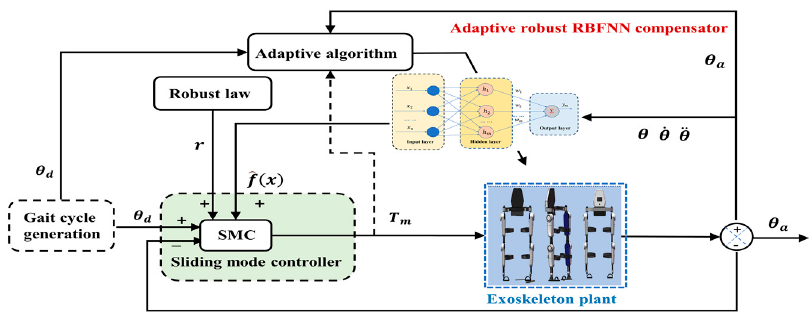
Figure 4. Scheme of SMC with robust adaptive RBFNN compensator.